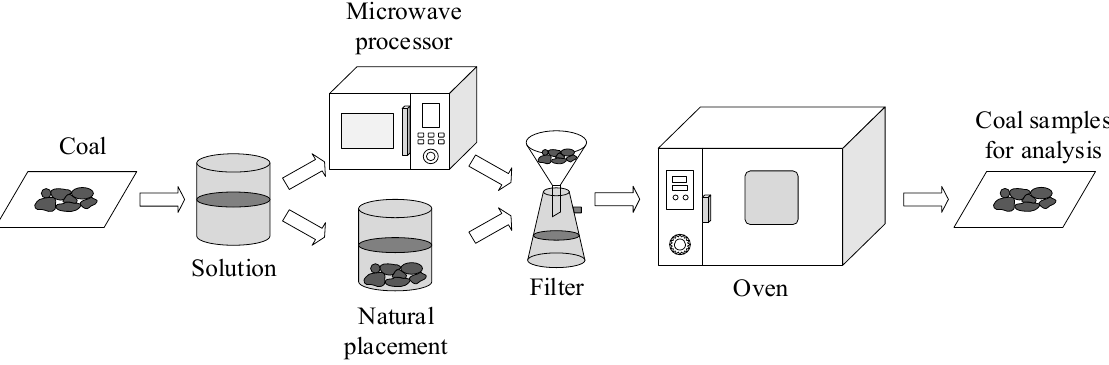
Figure 1. Schematic diagram of the Experiment Process.